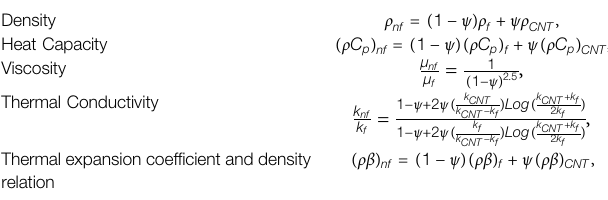
TABLE 2 | Mathematical expressions for nano fl uid thermophysical properties.